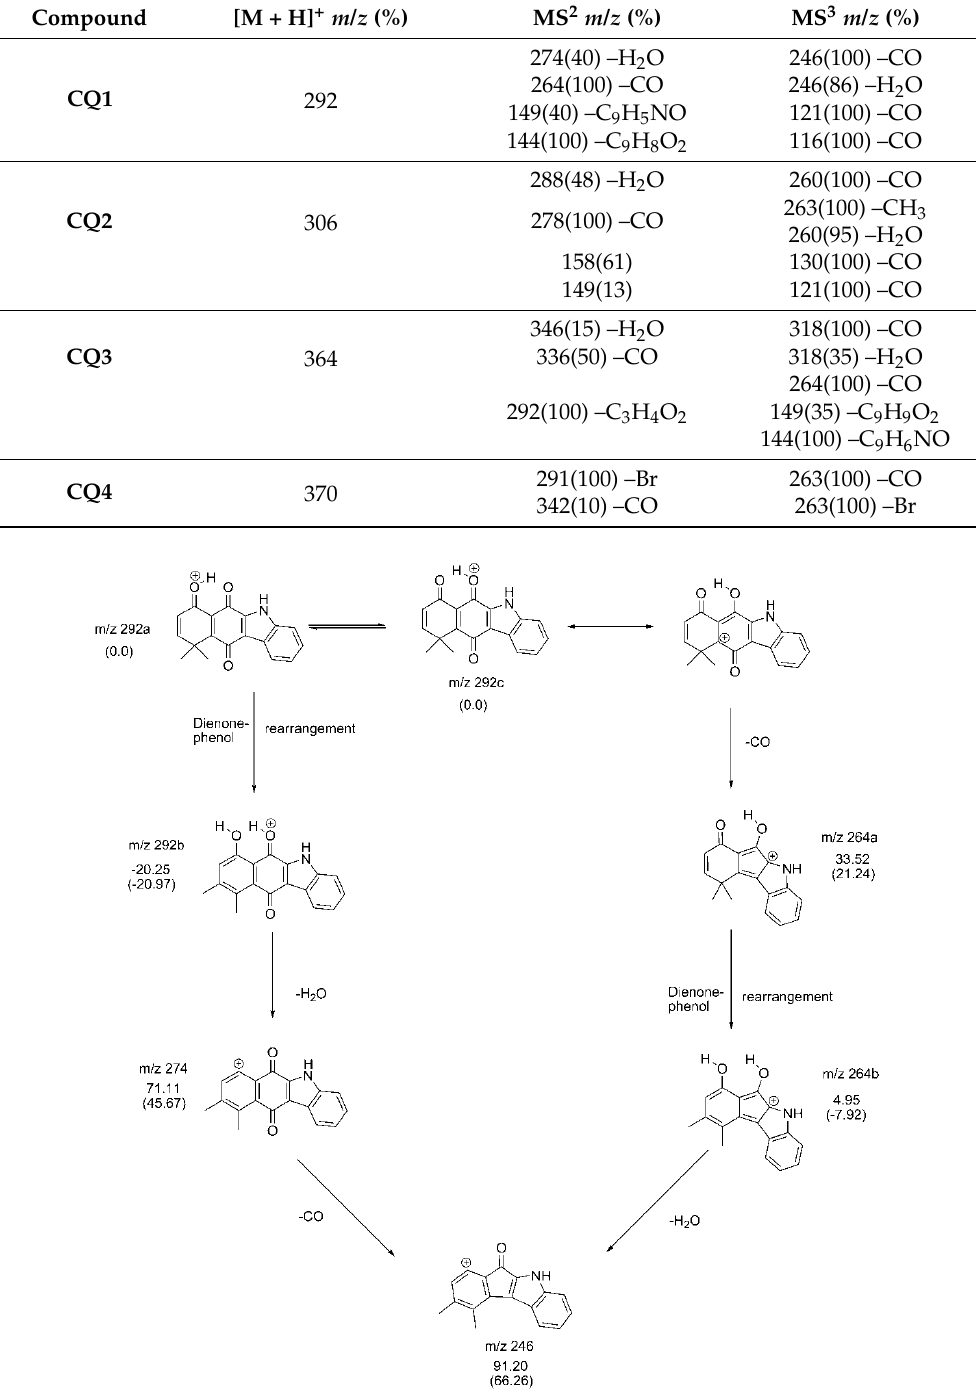
Table 4. Molecular and main fragment ions observed by ESI-MS n analysis of CQ1 to CQ4 .